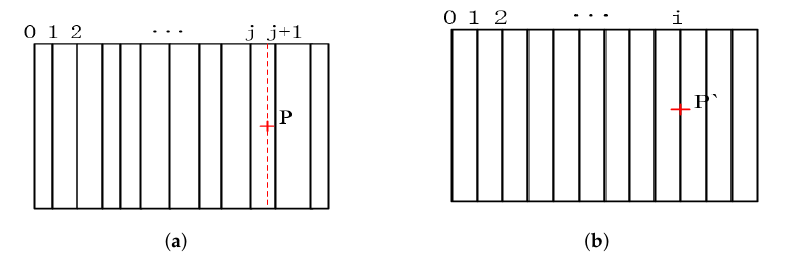
Figure 10. Illustration of the fine line-time normalization method: ( a ) sub-CCD image before fine line-time normalization and ( b ) sub-CCD image after fine line-time